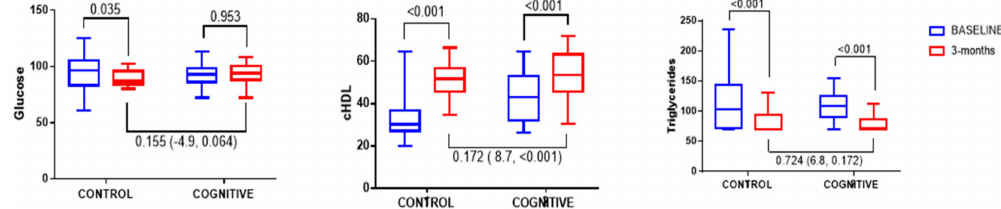
Figure 3. Change in biochemical characteristics after three months of intervention. Significance was analysed by an ANCOVA analysis, controlling for baseline biochemical values and sex. The estimated treatment e ff ect is described in